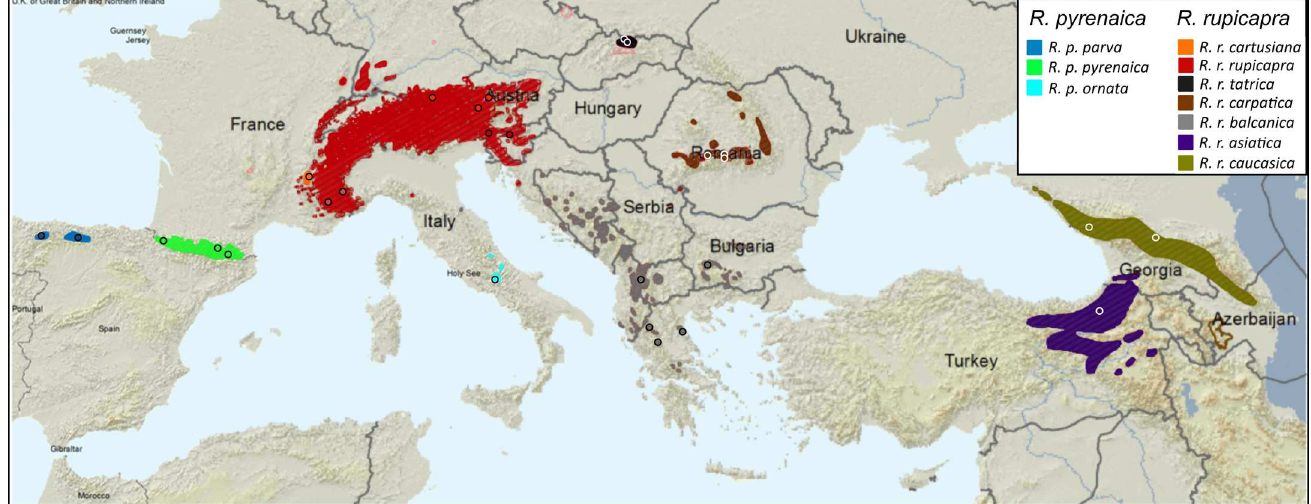
Fig 1. Geographic distribution of the subspecies of the genus Rupicapra [19]. The map was modifiedfrom the distribution map on the IUCN Red